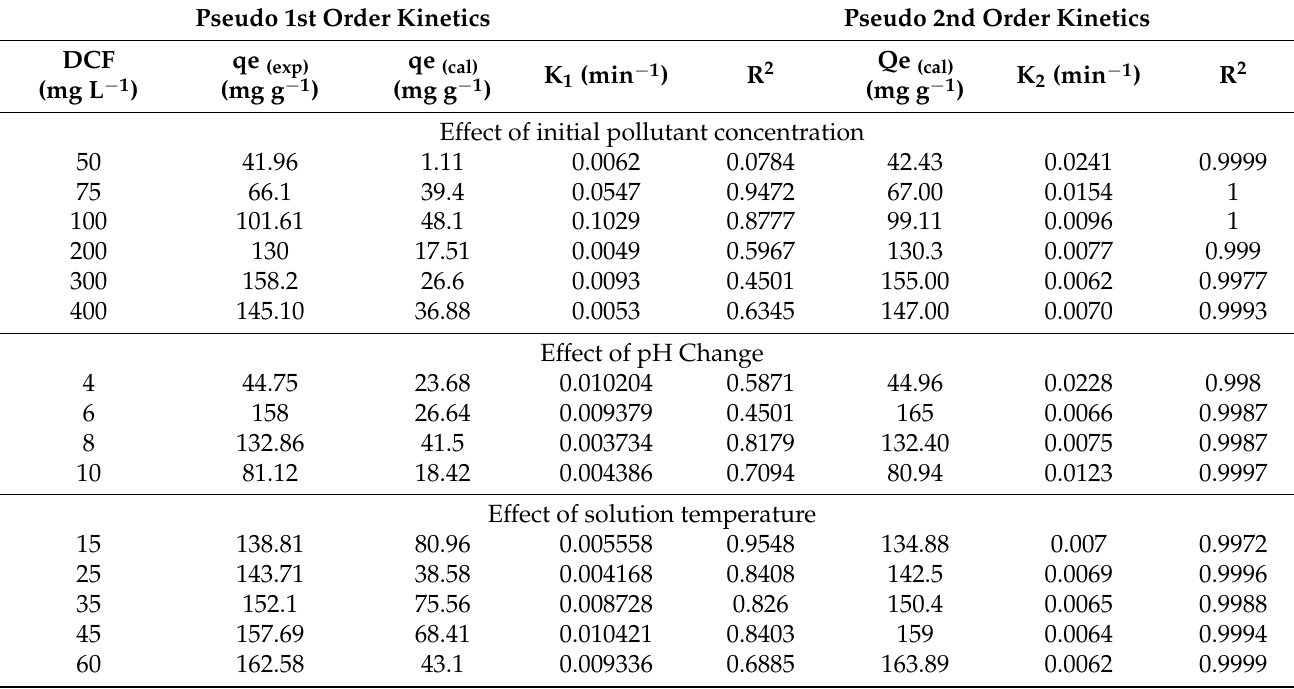
Table 1. Kinetics of diclofenac adsorption on to g-C 3 N 4 /MoO 3